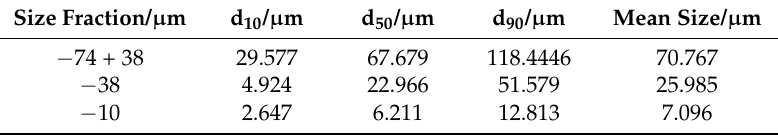
Table 2. The size distribution of narrow size fractions.